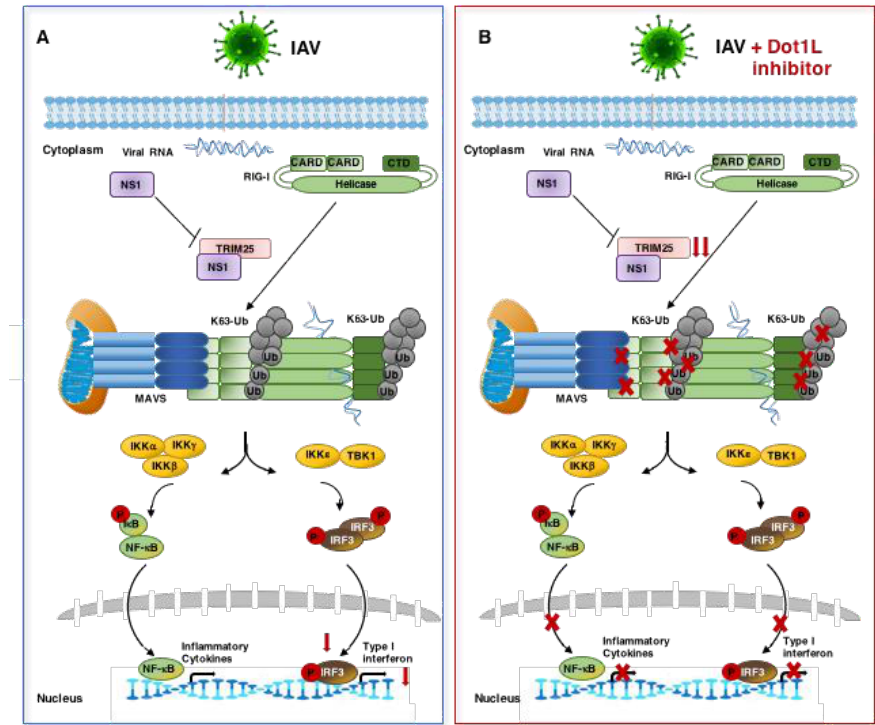
Figure 9. The effects of Dot1L inhibition in influenza virus infected cells. ( A ) Influenza virus infection stimulates the production of inflammatory cytokines and type I interferon through the RIG-I signaling pathway. The NS1 protein interacts with TRIM25 and partly counteracts IFN signaling. ( B ) In Dot1L-inhibited and infected cells, there is a decrease of TRIM25 expression that elicited impaired RIG-I ubiquitination, RIG-I-MAVS association, and NF- κ B and IRF3 activation. The production of inflammatory cytokines and type IFN are reduced, which decreases the antiviral response activating virus replication.